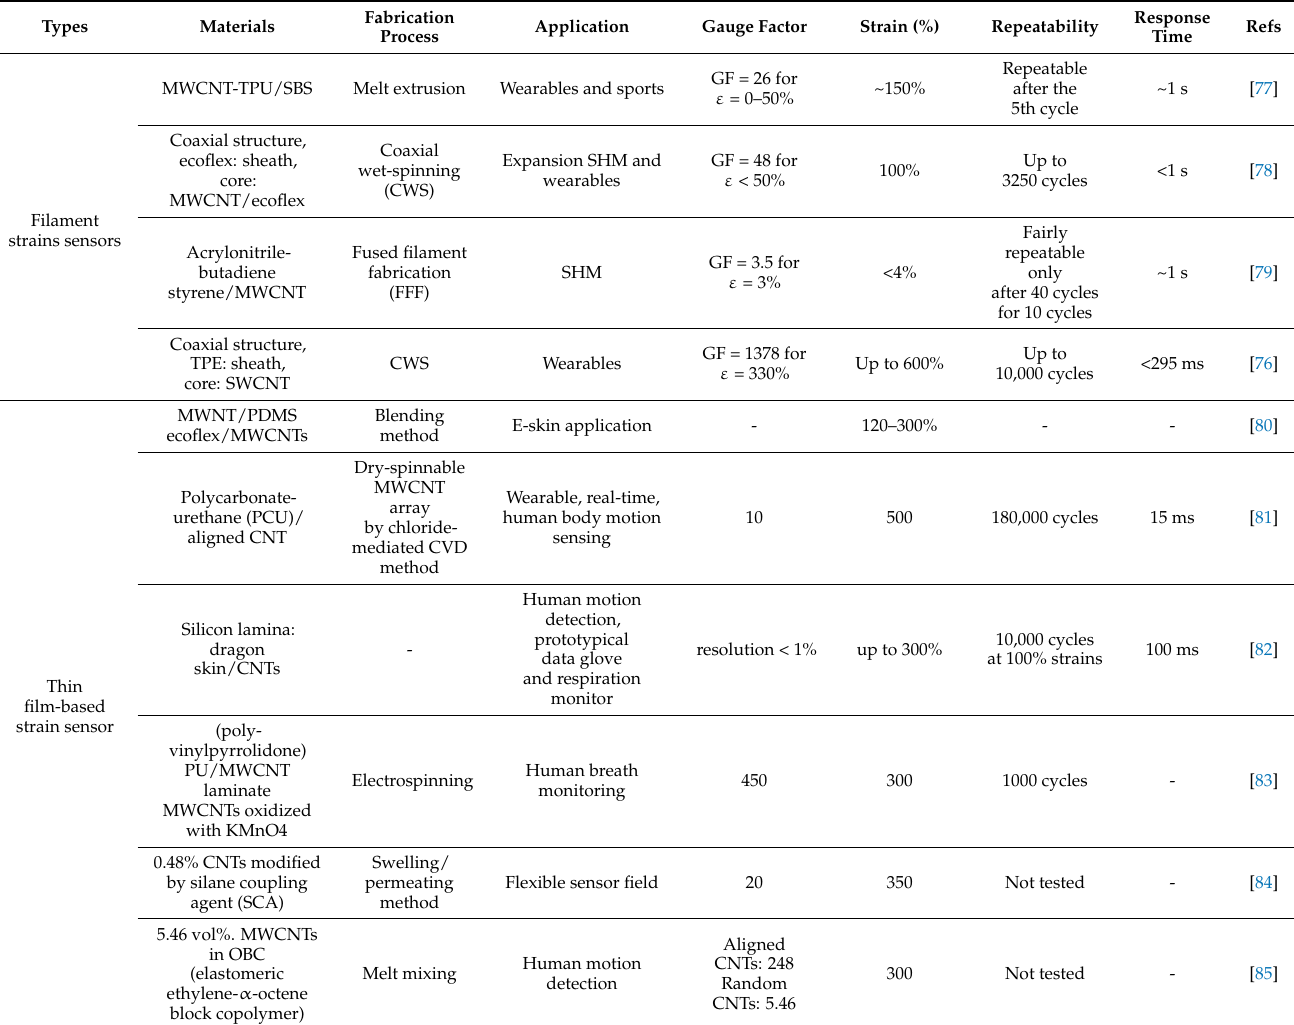
Table 3. Stretchable and flexible polymer/CNTs matrices’ sensor